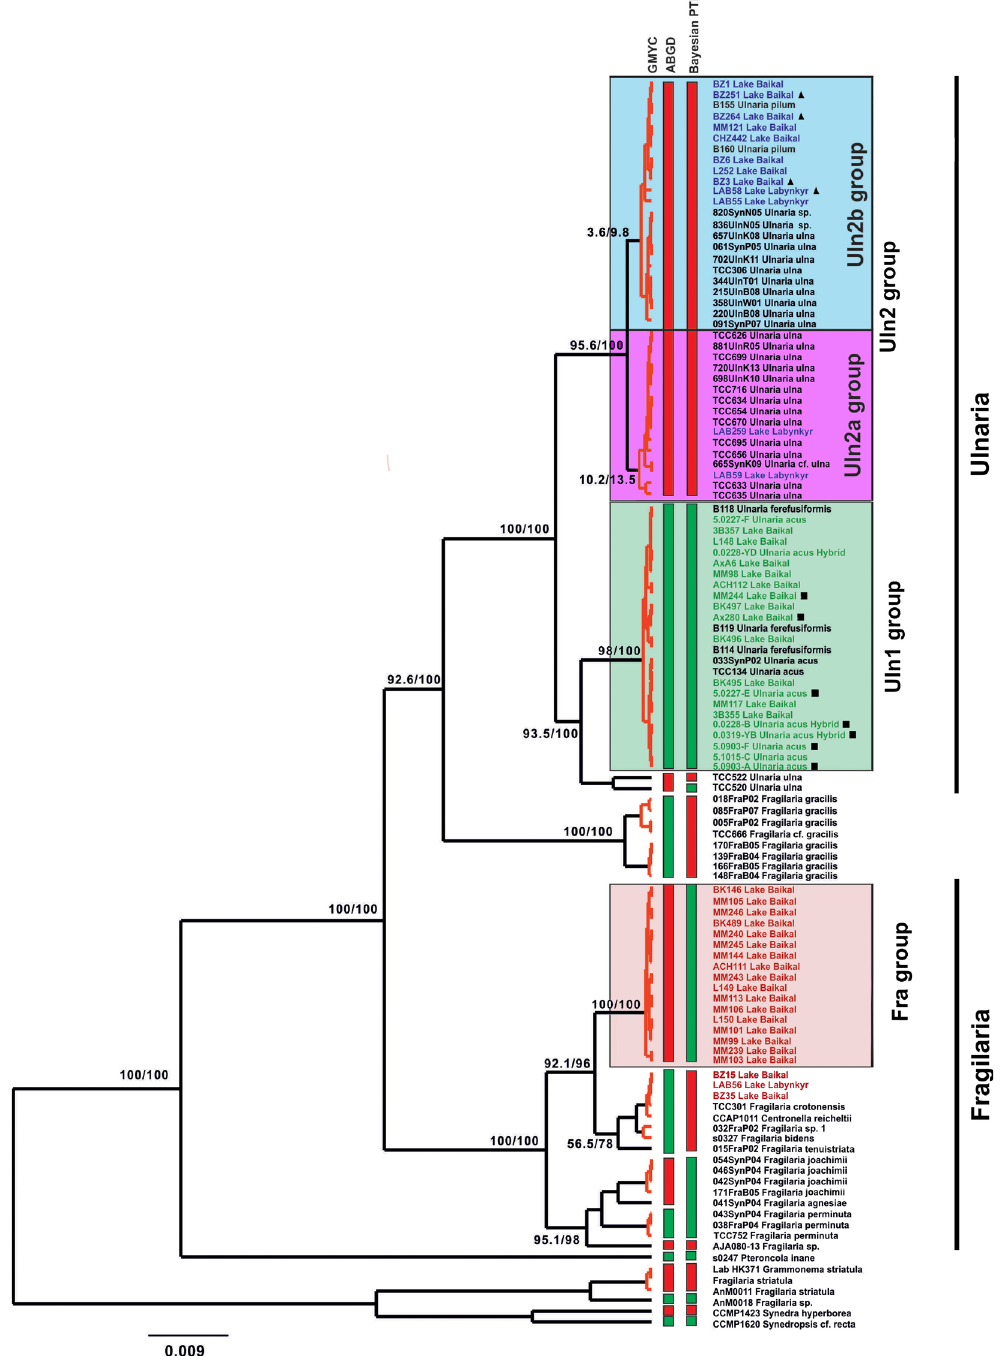
Figure 1. Bayesian phylogenetic tree reconstructed based on the rbc L genetic marker (BEAST pro- gram). The nodes for the key clusters specify ultrafast bootstrap maximum likelihood supports and Bayesian posterior probabilities. Clusters of species-level sequences identified by the results of GMYC delimitation are highlighted in red. Each black branch represents a species represented by one sequence. The results of species delimitation by the ABGD and Bayesian PTP methods are indicated by alternating rectangles (red and green), highlighting the clusters of species-level sequences. The sequences obtained in this study were included in three different groups: Fra (red), Uln1 (green) and Uln2 (Uln2a—fuchsia and Uln2b—blue).